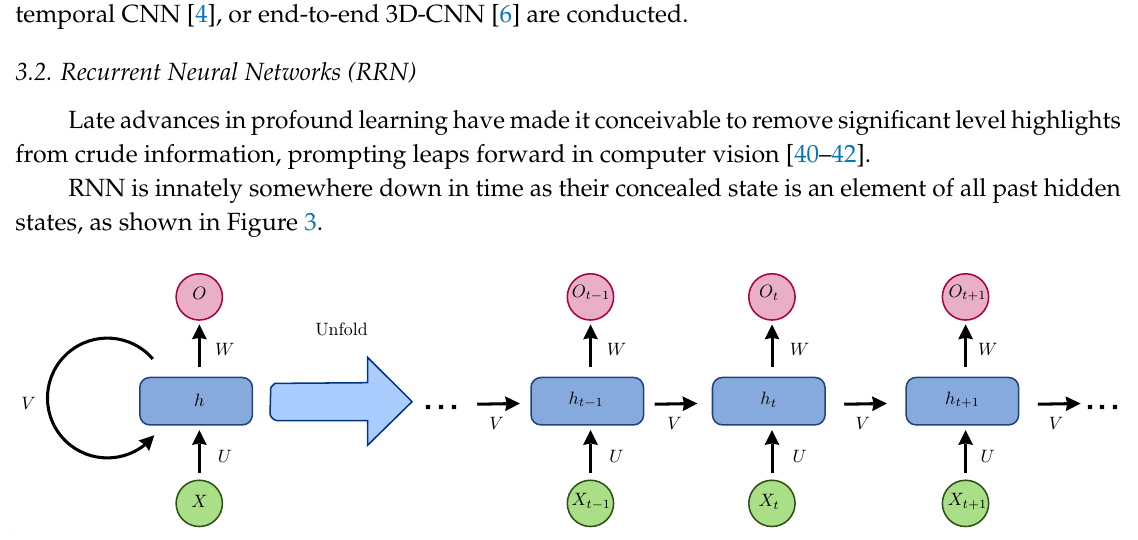
Figure 3. Recurrent neural network and the unfolding in the computation time involved in its forward